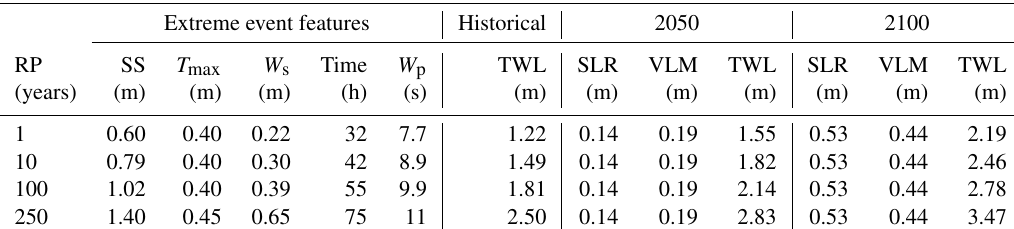
Table 1. Components of nearshore TWL for four ESL scenarios (RPs) designed according to analysis of historical ESL events and projected MSL change (2050 and 2100), accounting for both SLR (RCP4.5) and the average VLM rate.